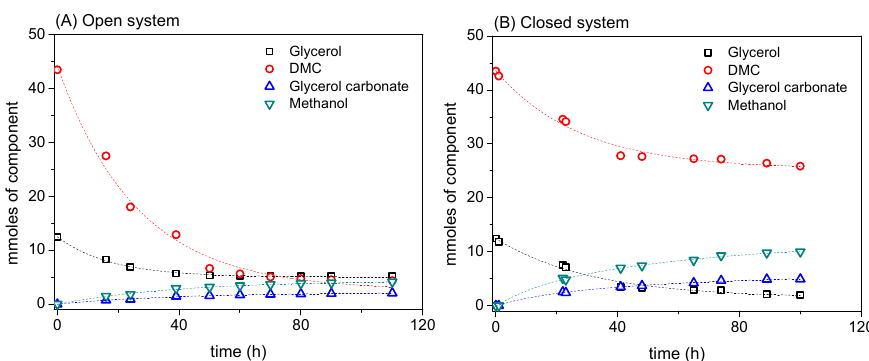
Figure 7. Evolution of the presence of reactants and products in the reaction mixture of reaction 2 for ( A ) the open system and ( B ) the closed system. Conditions: T = 60 °C ; EC:Gly = 3:1; enzyme load: 3% w / w ; solvent: tert-butanol (30% v / v ) agitation speed: 400 rpm.